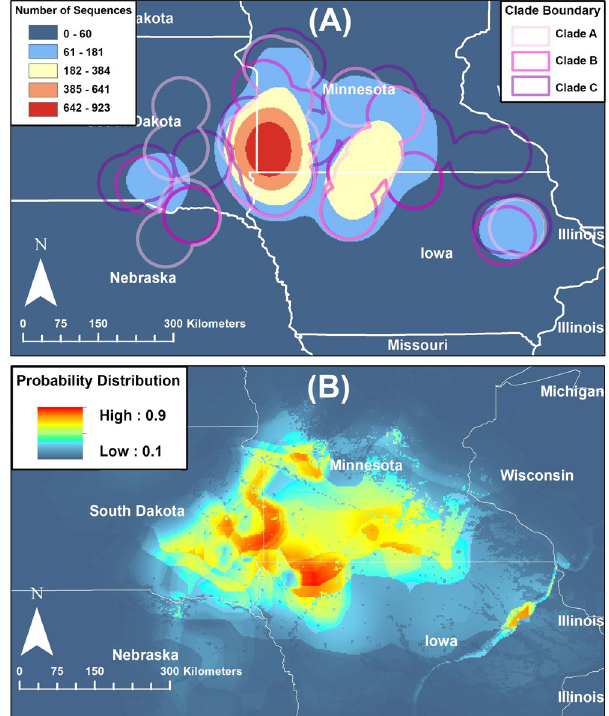
Figure 1. Geographical locations of the PRRSv sequences and predicted spatial probability of PRRSV outbreaks in swine farms located in the Midwest region of the U.S., collected from January 1998 to April 2016. ( A ) Smoothed kernel density function for the geographical locations of the farms where sequences were collected and geographical exntension of the selected clades. ( B ) Spatial probability distribution of PRRSV outbreaks predicted by the final presence-only maximum entropy ecological niche model. Figure’s maps were generated using ArcGIS version